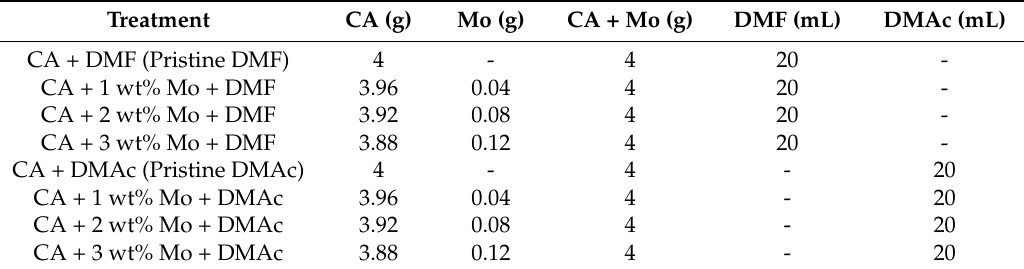
Table 1. Mixture of M. oleifera , cellulose acetate and solvents (dimethylformamide (DMF) or dimethylacetamide (DMAc)) used in this